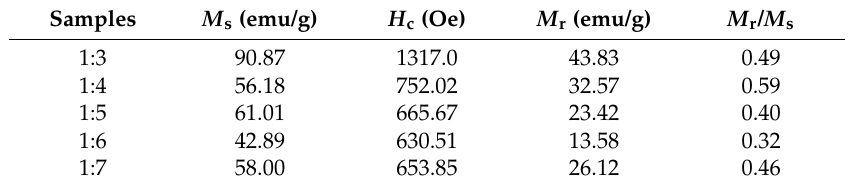
Table 4. Saturation magnetization M s , coercivity H c , and remanence M r , of BaFe 12 O 19 at different ratios. Samples